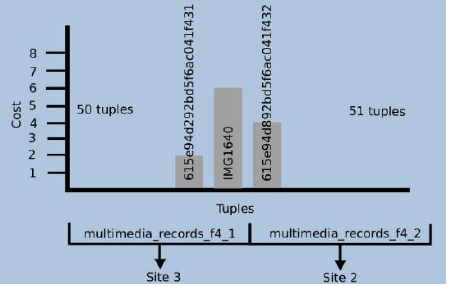
Figure 10. Dynamic horizontal fragmentation of multimedia_records_f4 .